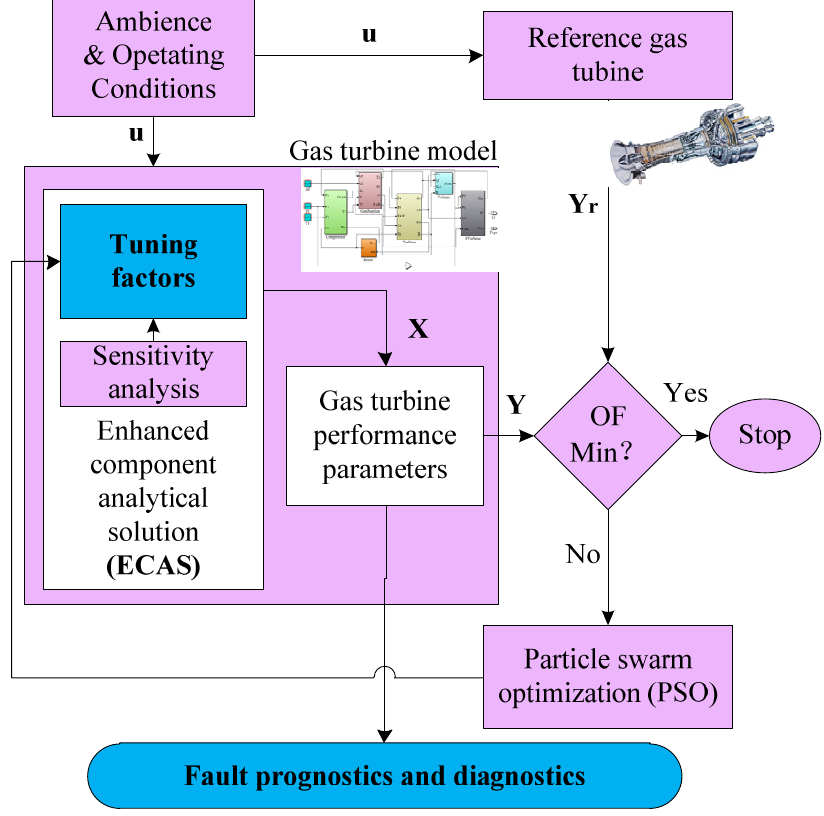
Figure 2. Flow chart of the proposed adaptation and diagnostics method. The measured gas turbine behavior is represented either by the field data of the in- service gas turbine or through the initial gas turbine model. For testing our proposed method, the reference gas turbine is a gas turbine model that uses the initial component analytical solution. In contrast to the proposed enhanced component, analytical solution is employed by the gas turbine model. The performance adaptation and diagnostics method is depicted in Figure 2. The independent parameter vector X is tuned to minimize the deviation of the dependent parameter between the actual gas turbine Y and the reference gas turbine Y r . For this study, the difference between the predicted Y and the observed Y r can be evaluated by an objective function ( OF ) that is defined as follows: